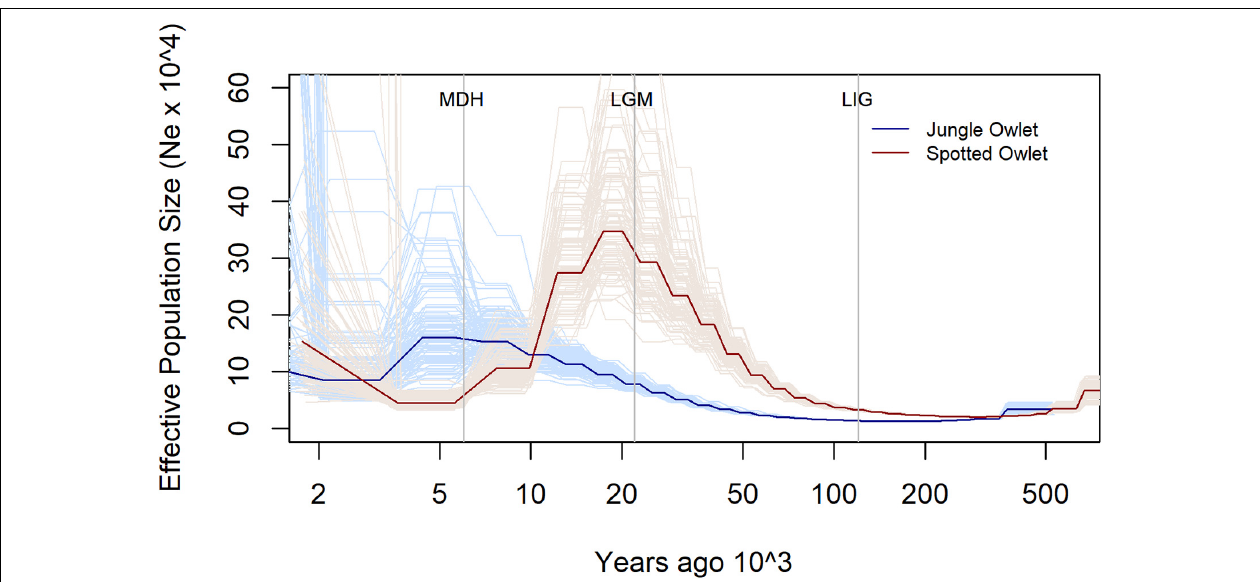
FIGURE 1 | Estimated change in effective population size (N e ) for the Jungle ( Glaucidium radiatum , dark blue) and Spotted ( Athene brama , dark red) Owlets over the past 500,000 years. The pale lines denote estimates from the 100 bootstrap replicates for each species. The vertical lines denote significant climatic transitions in the past—the Last Interglacial (LIG—120,000 YBP), the Last Glacial Maximum (LGM—22,000 YBP), and the Mid-Holocene (MDH—6,000 YBP). To scale the plot, a mutation rate of 4 × 10 − 9 per site per year and a generation time of 2 years were